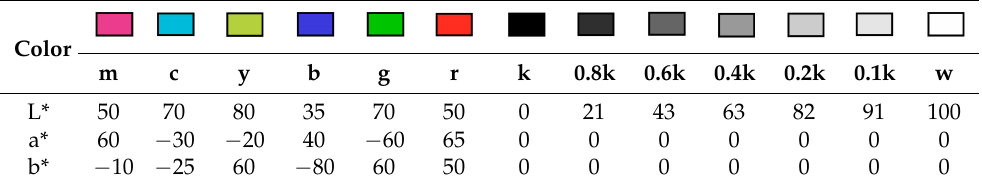
Each color stair is composed of 6 color bars and 7 achromatic bars. The color sequence from left to middle on each color stair is m (magenta), c (cyan), y (yellow), b (blue), g (green), and r (red), and the achromatic bars from middle to right are k (black), 0.8k (80% gray), 0.6k (60% gray), 0.4k (40% gray), 0.2k (20% gray), 0.1k (10% gray), and w (white). The corresponding setting L*, a*, and b* values of the above test colors are shown in Table 2. Table 2. The original test colors in the experiment and corresponding chromaticity values.